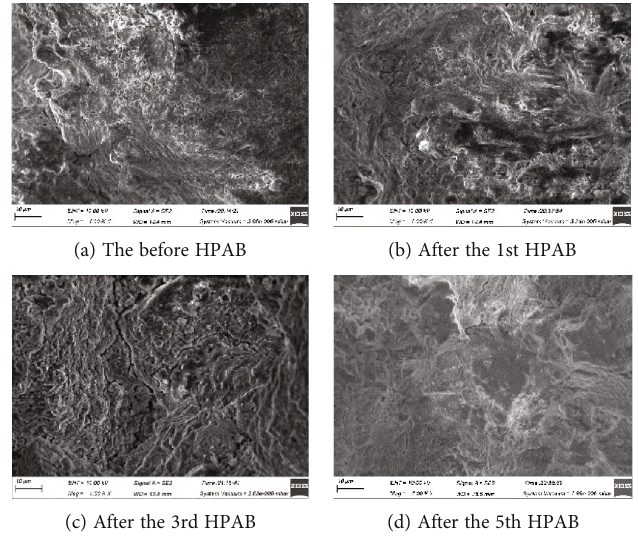
Figure 10: The comparison of SEM images under multiple HPAB